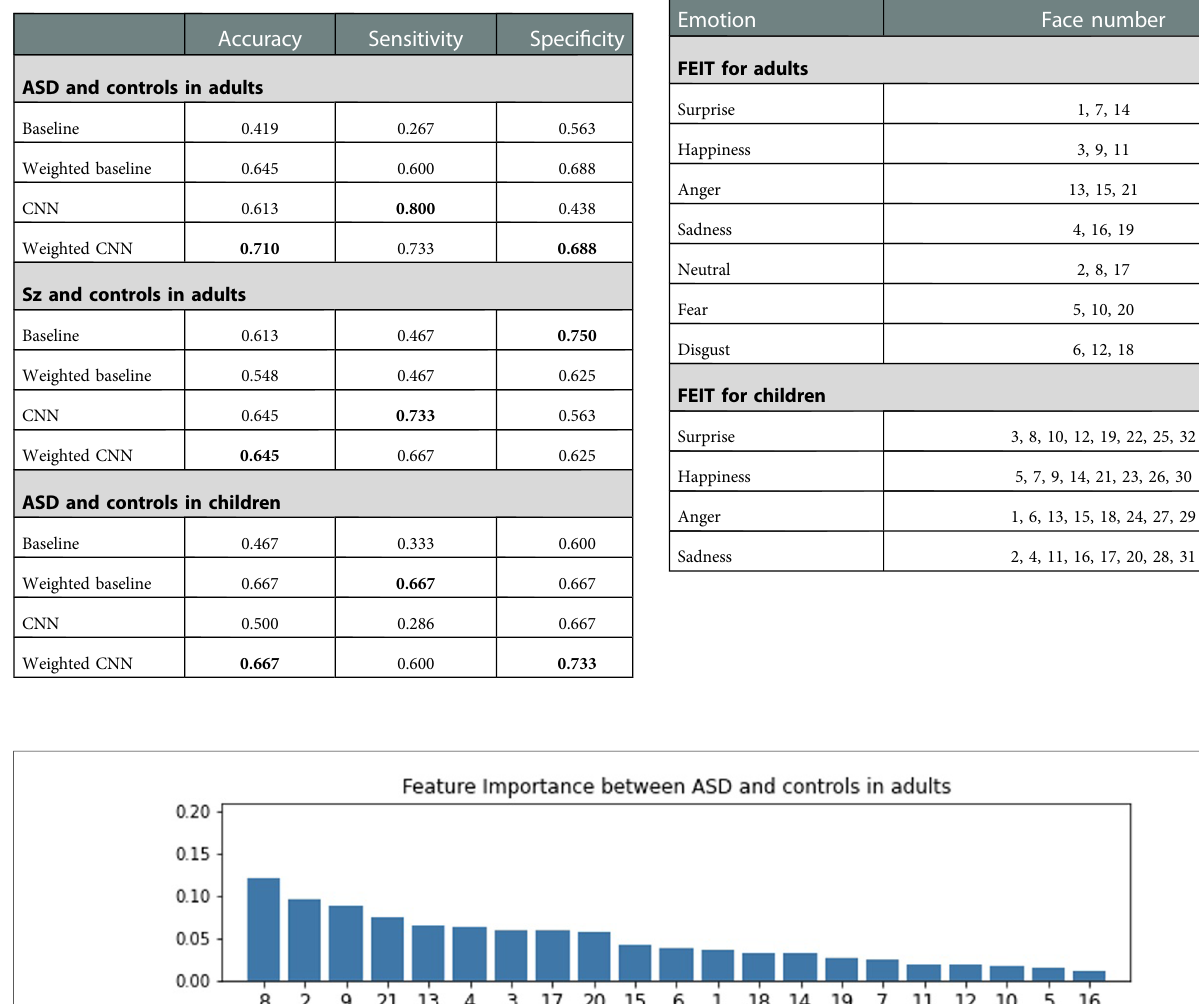
TABLE 6 Results of classi fi cation of ASD and controls in adults, Sz and controls in adults, and ASD and controls in children: Best results are shown in bold.